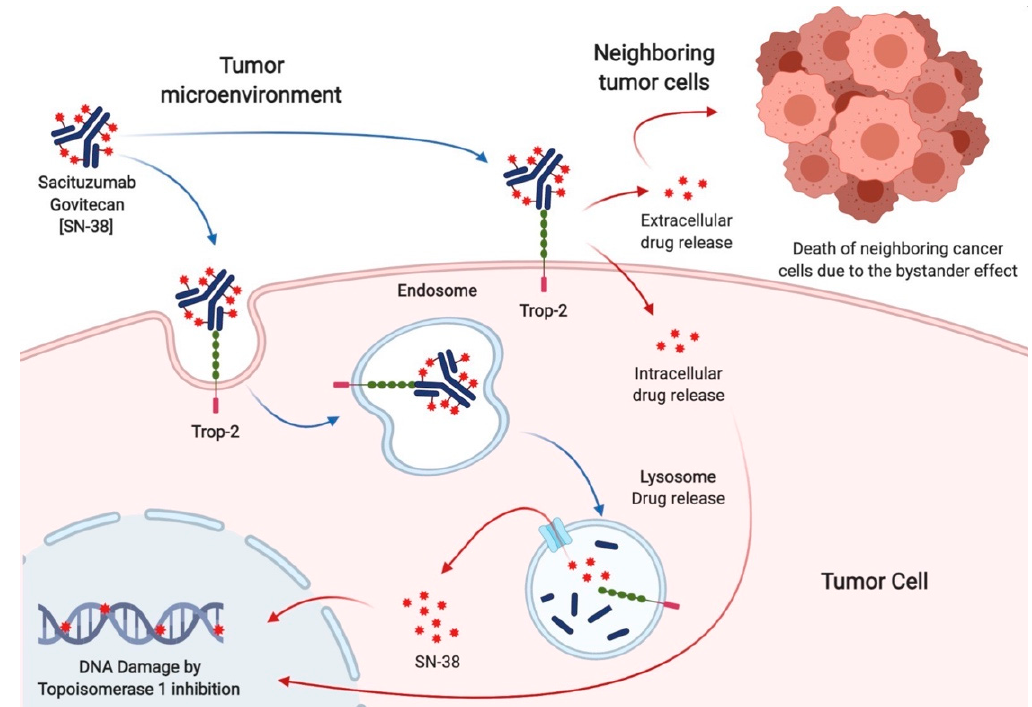
Figure 2. Mechanism of action of Sacituzumab govitecan. The humanized monoclonal antibody (hRS7) allows the internalization of the cytotoxic payload (SN38) into the tumor cell after binding with the surface receptor Trop-2. The hRS7 complex bound to Trop-2 is internalized through an endosomal vesicle that carries it to the lysosomes. Free SN-38, released after antibody catabolism and linker hydrolysis within the lysosome, induces DNA damage due to the inhibition of topoisomerase 1. Furthermore, the hydrolyzable linker enables SN-38 to be released into the tumor microenvironment. Given its membrane-permeable nature, free SN-38 can also exert its effect on neighboring cancer cells. Thus, tumor cells that express Trop-2 on the surface undergo the cytotoxic effect of SG by the intracellular uptake of SN38, whereas the adjacent ones experience this effect by its extracellular release (the so-called bystander